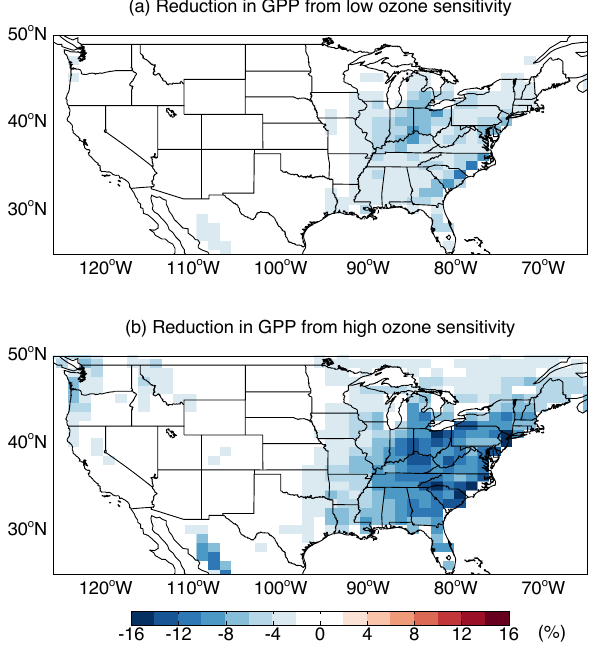
Figure 8. Simulated reduction fraction in summer GPP in the US Fig. 8. Simulated reduction fraction in summer GPP in the U.S. due to (a) low and (b) 1188 due to (a) low and (b) high O 3 sensitivity for 1998–2007. estimates. For example, Xiao et al. (2010) upscaled site-level GPP flux to continental scale with a regression tree approach based on both NACP fluxes and remote-sensing